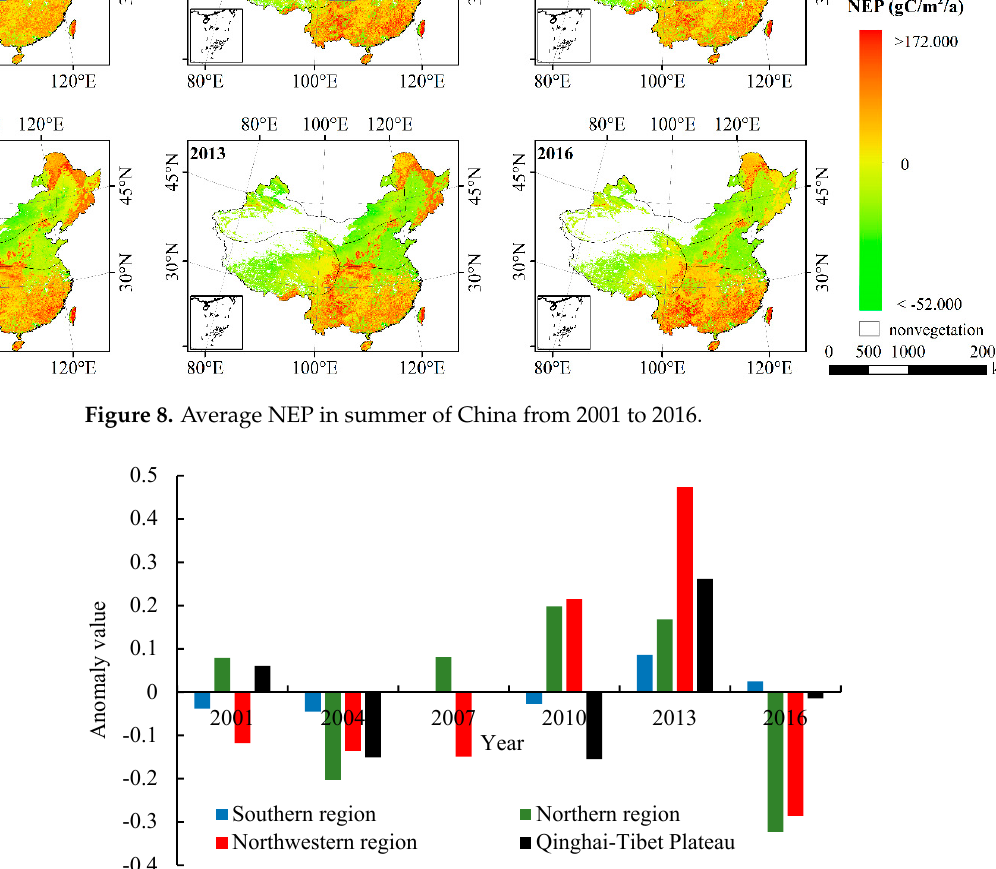
Figure 9. Inter-annual changes NEP in different geographic areas.